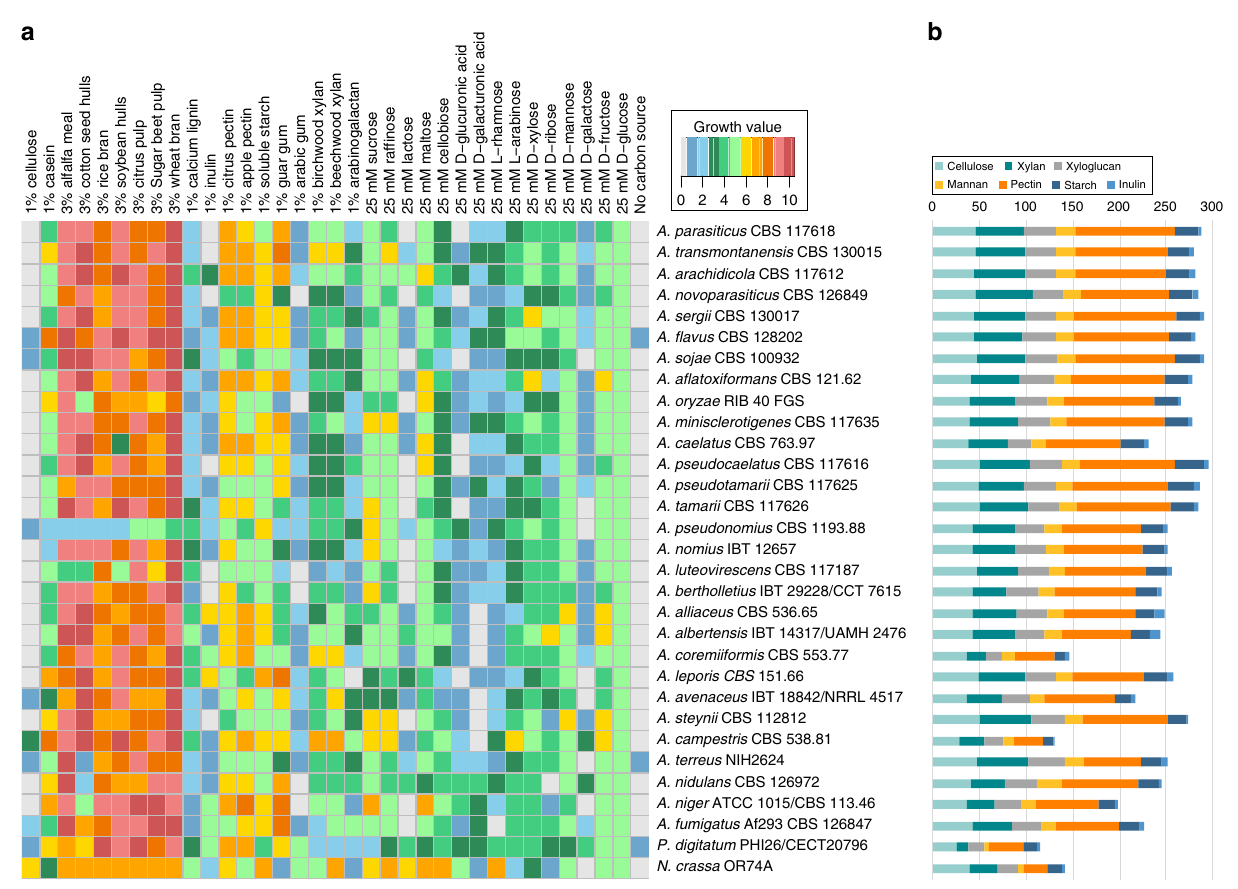
Fig. 5 Carbohydrate-active enzymes in section Flavi sorted according to the phylogram of Fig. 1. a Heatmap representing the growth pro fi les of 23 Flavi species and 8 additional species on 35 different media. b Comparison of the CAZyme sets related to plant biomass degradation in the genomes of species from Aspergillus section Flavi , and some other fungi. The colors re fl ect the polysaccharides the enzymes are active